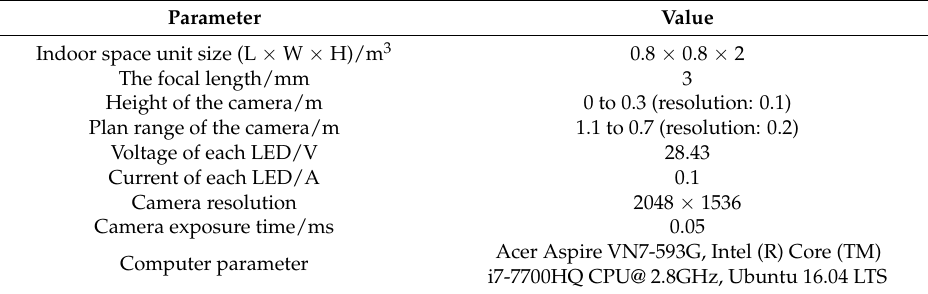
Figure 8. The circuit board of transmitting terminal.